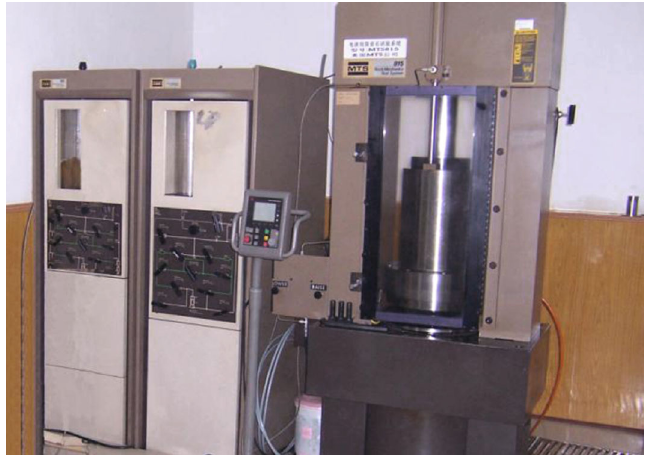
Figure 2: MTS815.02 electrohydraulic servocontrolled rock mechanics testing system.